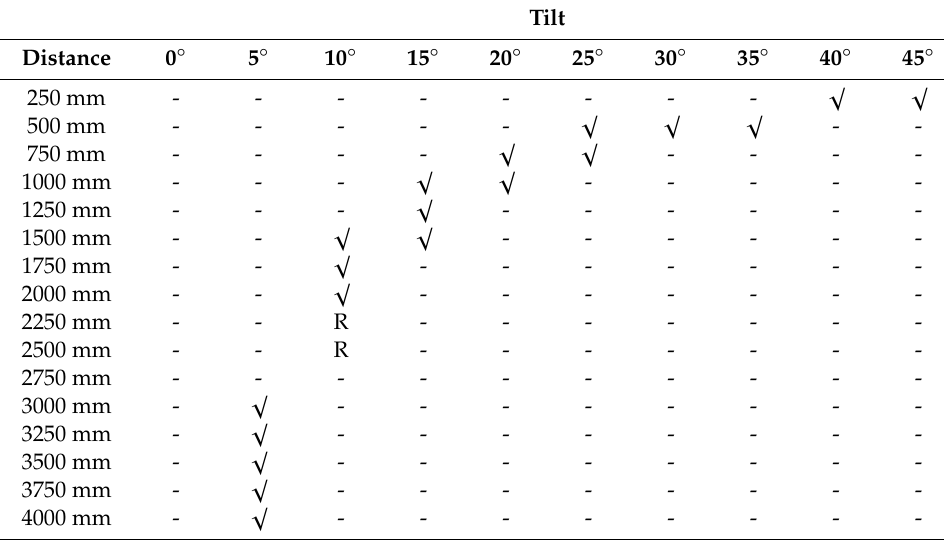
Table 2. Small box detection results obtained for di ff erent distances and LIDAR tilt angles: ( detected, (R) object detected after ground reflection, (-) object not